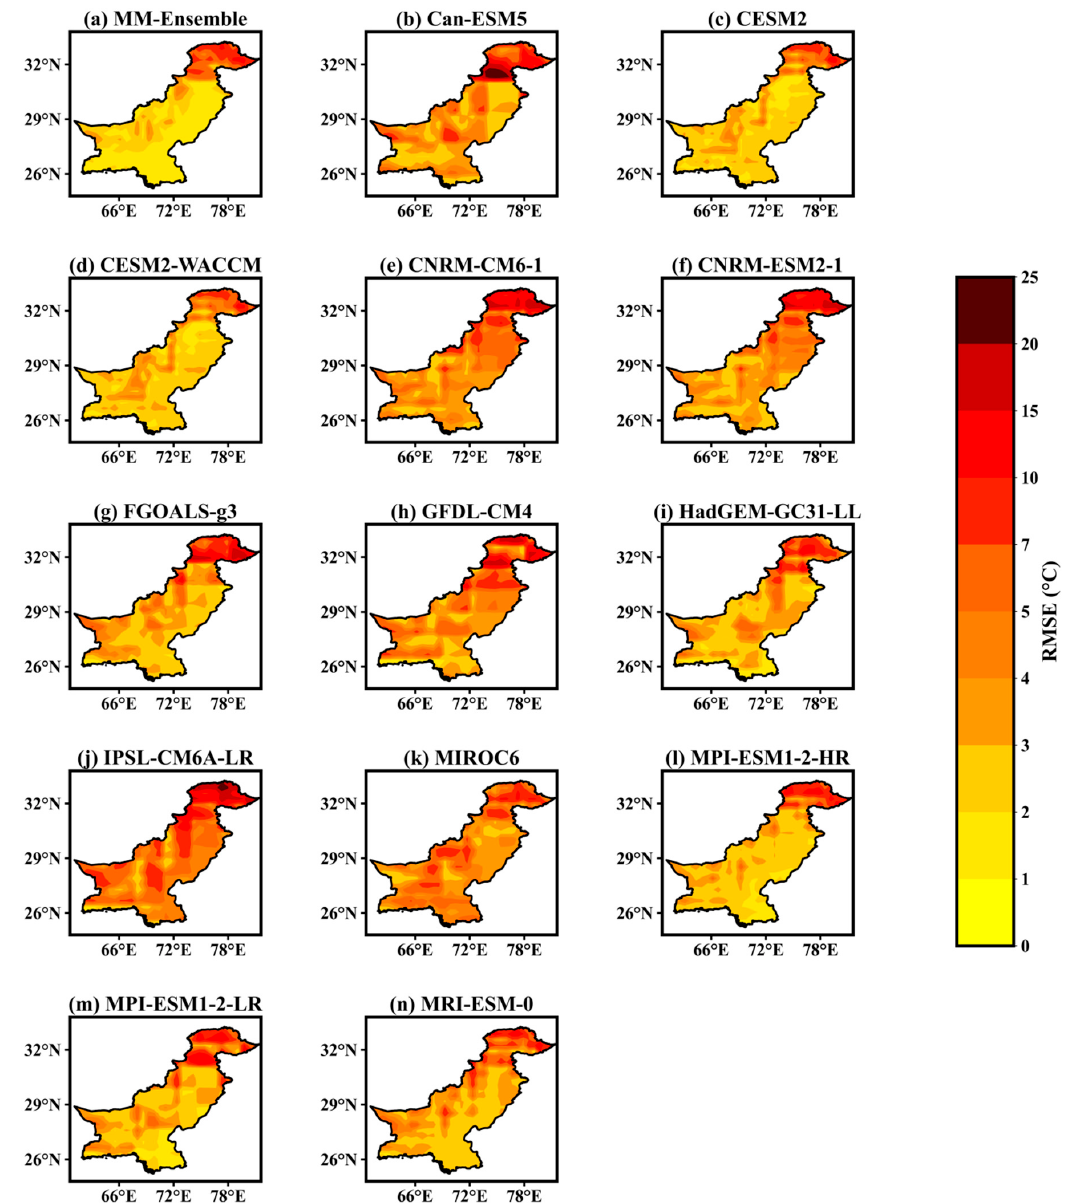
Figure 14. Same as Figure 11 but for winter (DJF) season RMSE.